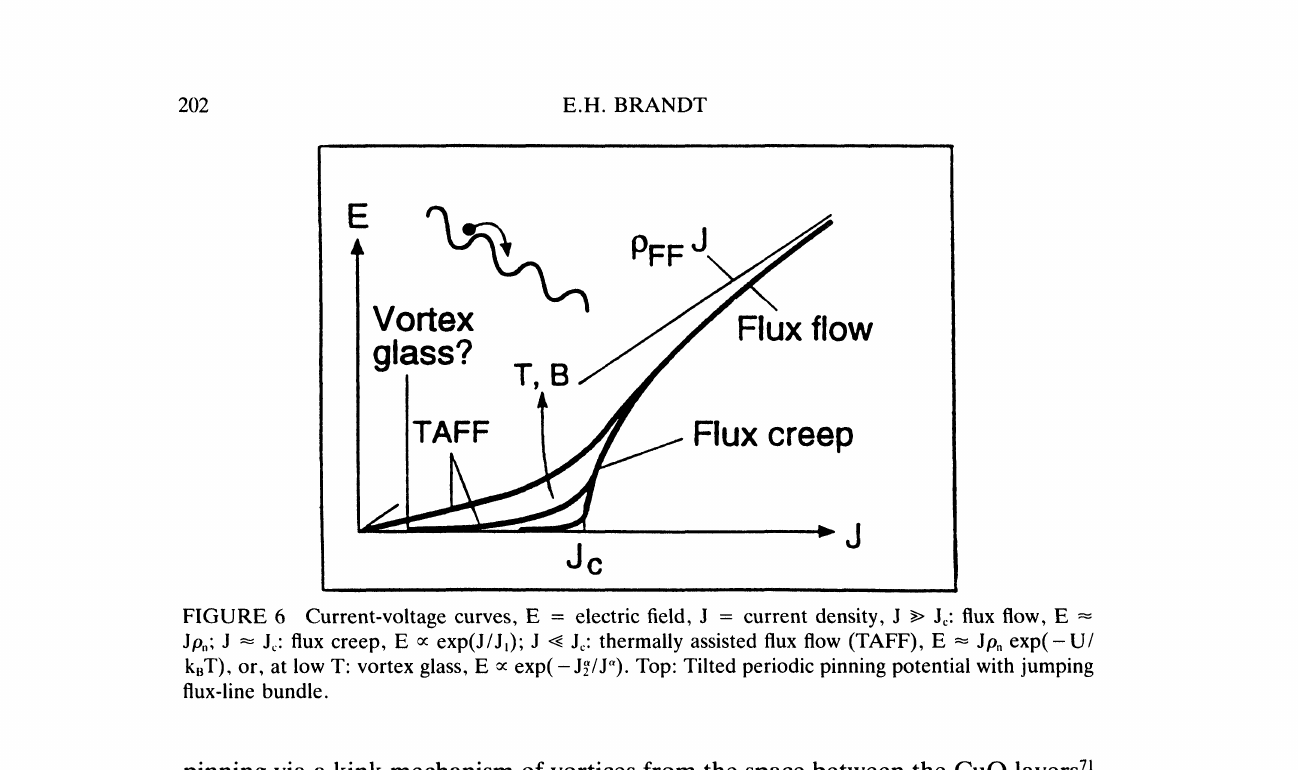
FIGURE 6 Current-voltage curves, E electric field, current